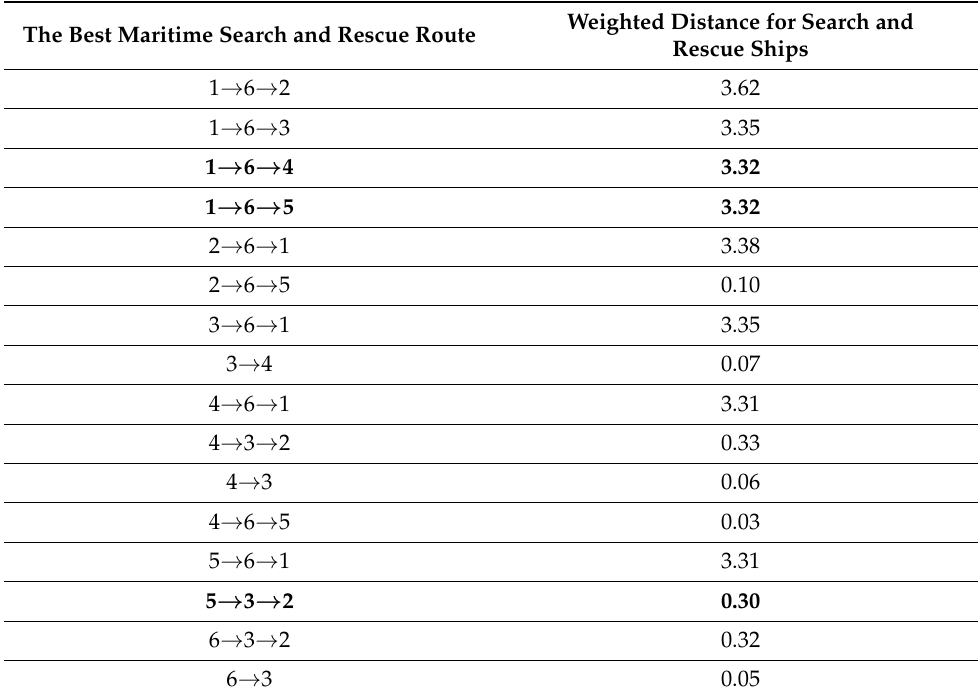
Table 8. Optimized search and rescue route results